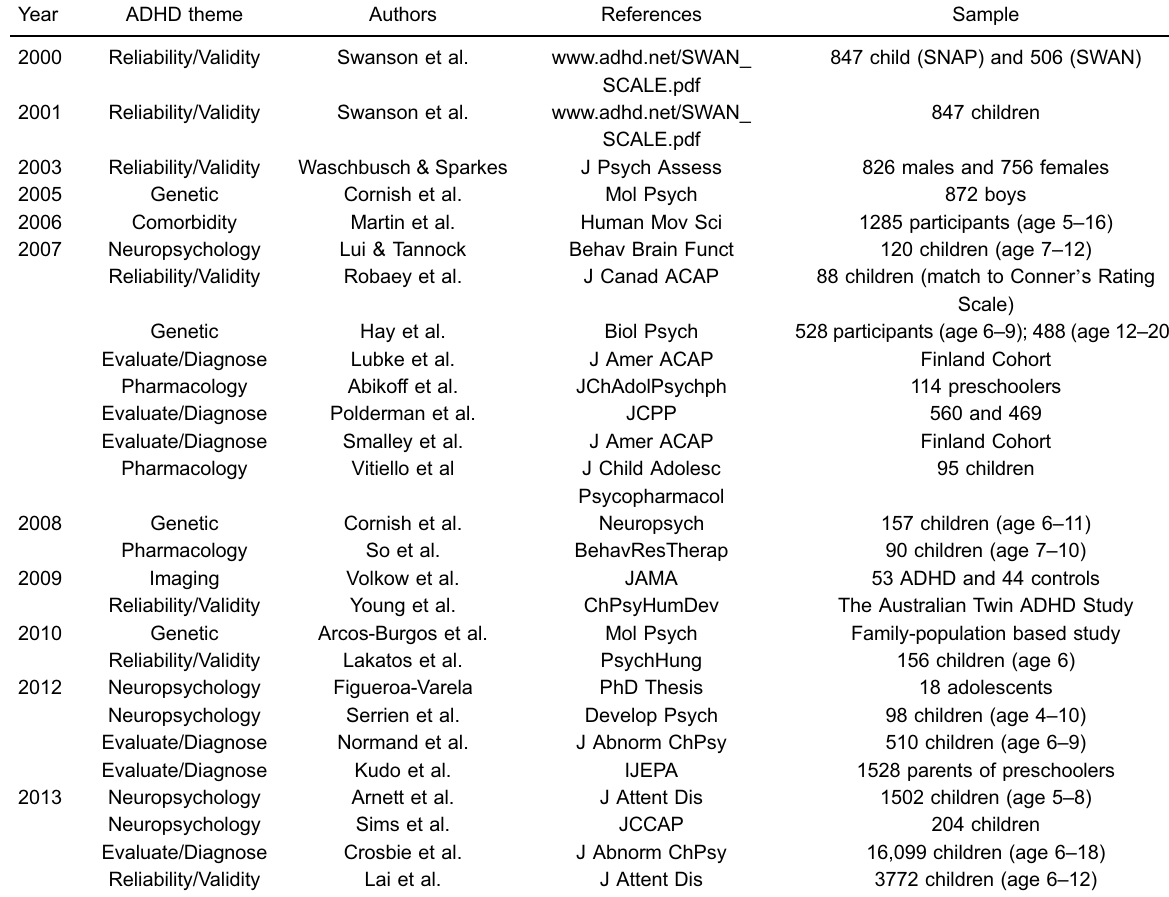
Table 1. The 27 articles on SWAN selected for review, and the areas of attention de fi cit hyperactivity disorder (ADHD) research, their authors, journals, and